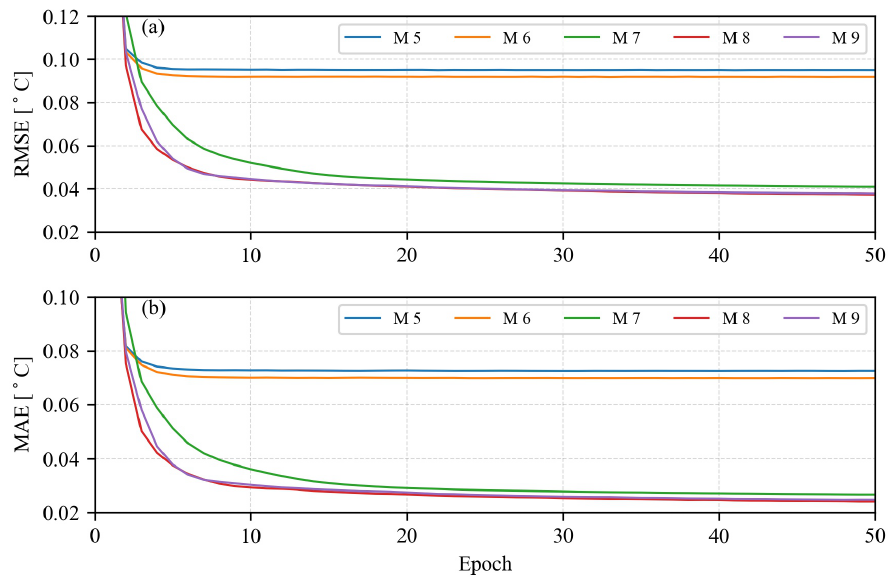
Figure 5. ( a ) RMSE and ( b ) MAE at each epoch for the five reconstruction models during training. In comparison, model 7 differs from model 6 by using ReLU as activation functions for the hidden layers. Yet the enhancement of the model performance is significant. The RMSE and MAE of model 7 are much lower than that of model 5/6. For instance, RMSE and